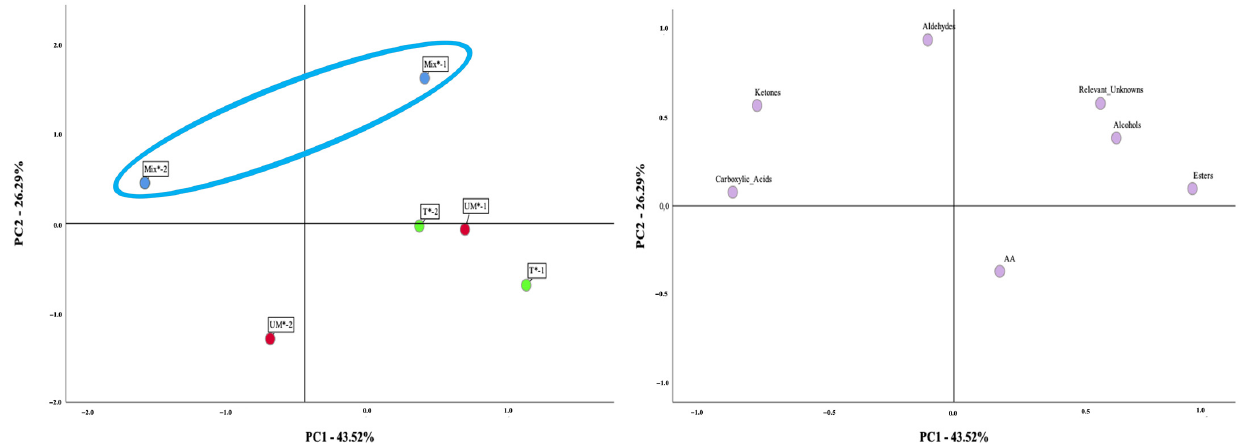
Figure 1. Principal component analysis (PCA) of total content of AA and VOCs data obtained for each Antão Vaz wines separated by chemical functional groups. Blue dots represent Mix* wine samples, green dots represent T* wine samples and red dots represent UM* wine sample. According to PCA performed for each chemical functional group, Figure 1, PC1 and PC2, accounted for 43.52% and 29.26% of the total system variation, respectively. It is